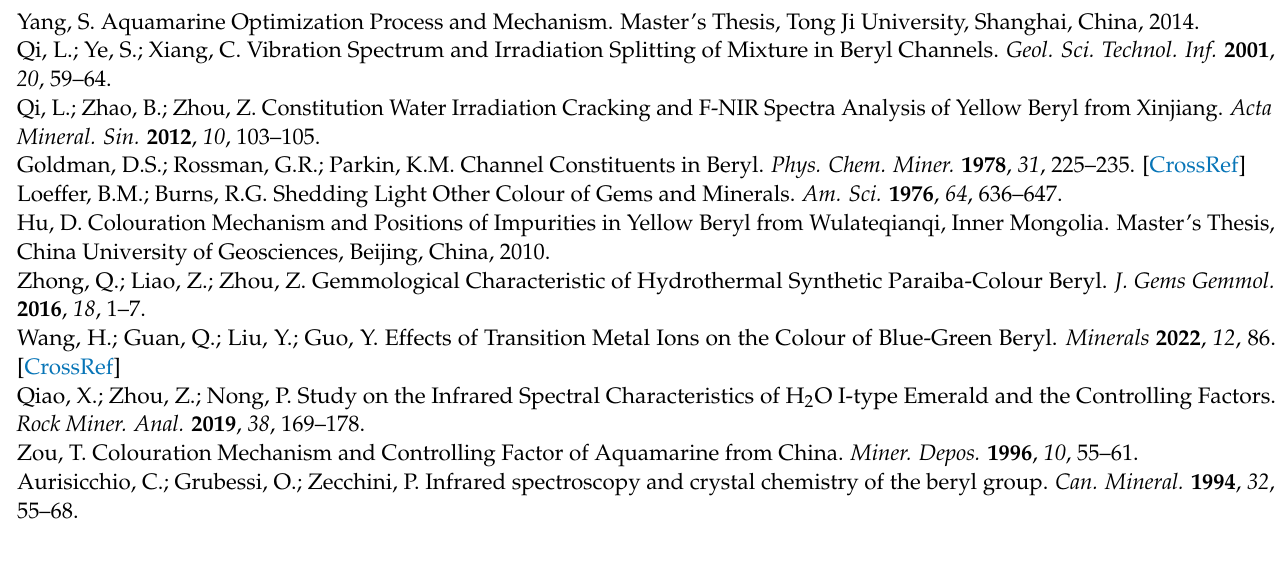
23 samples; Table S2: The test data of IR; Table S3: The main elements content of 23 samples tested by XRF; Table S4: The Fe 2+ content of 10 samples; Table S5: The test data of